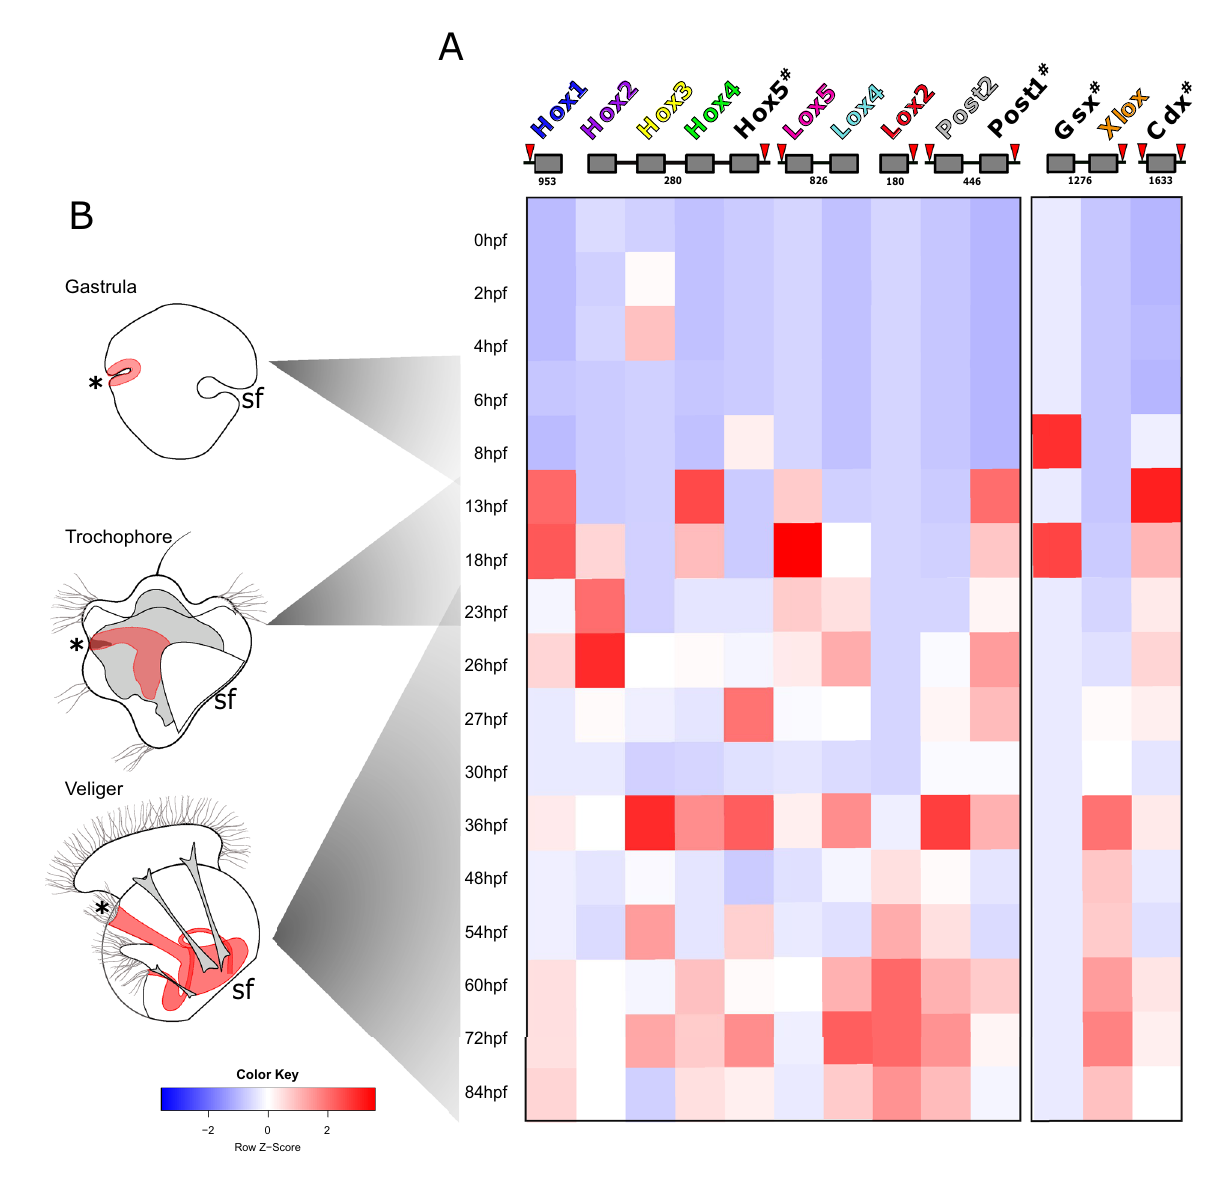
Figure 1. Relative quantitative analysis of Hox and ParaHox gene transcripts during development of Dreissena rostriformis . ( A ) Localization of Hox genes on scaffolds is shown in the upper part. Identification numbers of scaffolds where genes were found and location of non-Hox genes identified within the cluster are indicated by red arrowheads. Hashtags mark genes for which no expression data by in situ hybridization could be produced. ( B ) Heat map shows relative normalized expression levels for each gene (Z-score). Genes expressed above the normalization threshold are depicted in graded shades of red, those below the threshold in shades of blue. Time after fertilization and corresponding developmental stages at 23 °C are to the left. Germ layers and major derivatives in animal schemes are depicted in grey (mesoderm), red (endoderm), and white (ectoderm), respectively. Asterisks mark the blastopore/mouth, sf indicates the shell